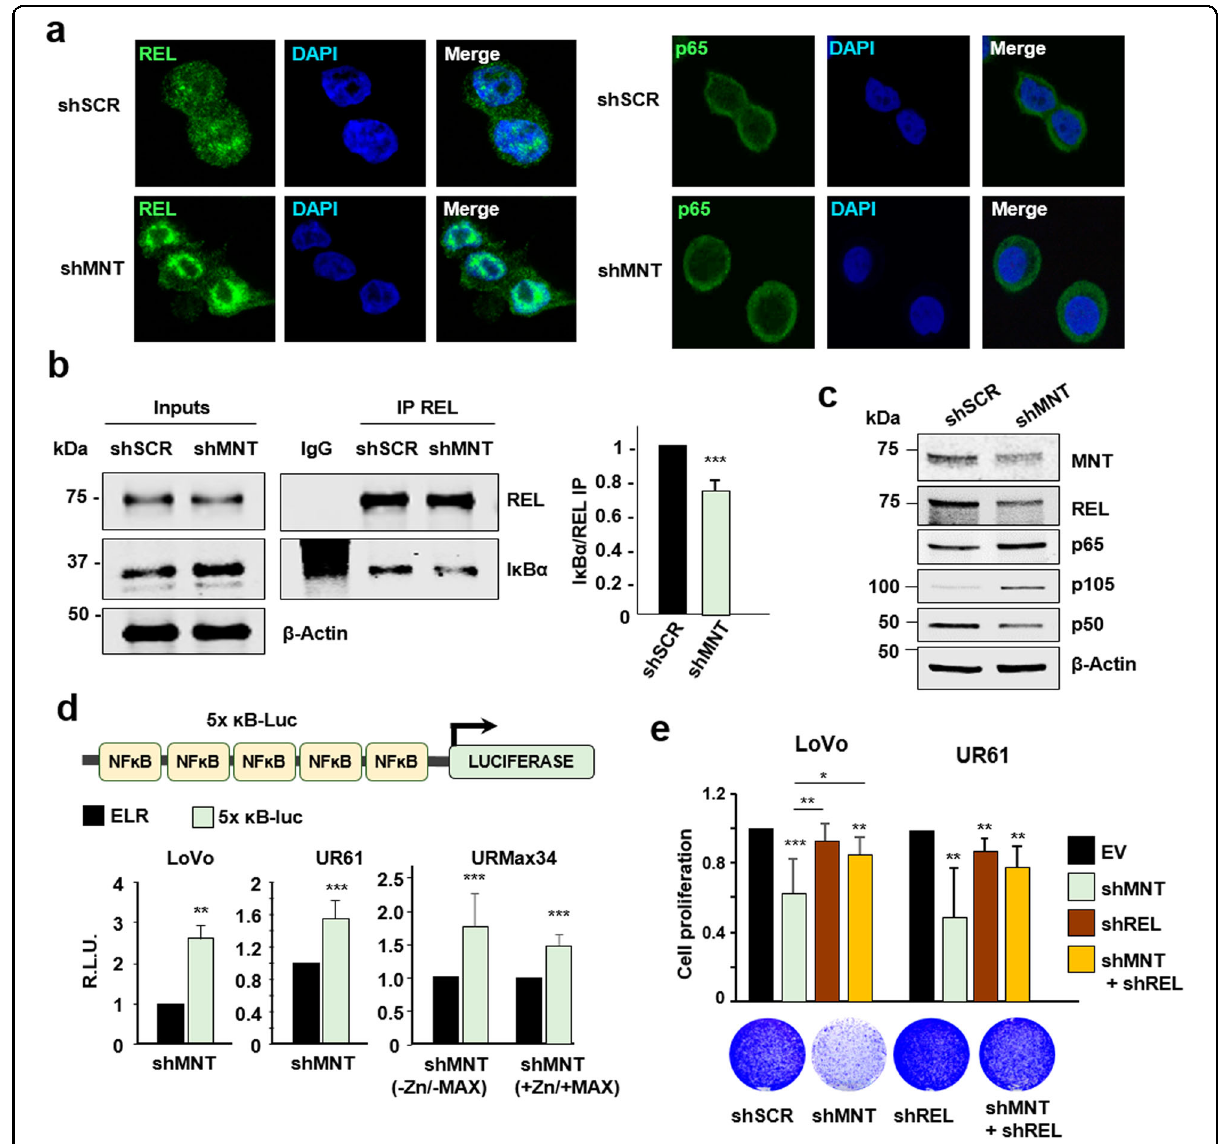
Fig. 4 MNT acts as a repressor of the NF- κ B ’ s pathway. a Immuno fl uorescence of REL (left panel) or p65 (right panel) in LoVo cells that were infected with lentiviral particles carrying two shRNAs against MNT (shMNT) or a scrambled shRNA (shSCR), and selected with puromycin (1 µg/mL) for 72 h. DAPI as a nuclear marker. b LoVo cell lysates 72 h after infection with shRNAs against MNT (shMNT) or a scrambled shRNA (shSCR), as control were immunoprecipitated with anti-REL antibodies (IgG as negative control). The immunoblots of REL and I κ B α in the inputs and the IPs are shown. Right graph: the protein levels of the I κ B α co-IP versus the REL IP in both conditions were quanti fi ed. The data are shown as the mean ± S.D., n = 2, ** P < 0.05. c Protein levels of MNT, REL, p65, p105/p50 in LoVo cells 72 h after infection with lentiviral particles carrying two shRNAs against MNT or a scrambled shRNA (shSCR), as a control. β -Actin used as a protein loading control. d Top: Schematic representation of the luciferase reporter driven by fi ve NF- κ B binding sites used in these experiments (pNF-kB-Luc). Bottom: NF- κ B-mediated promoter activity. LoVo cells were infected with lentiviral particles carrying two shRNAs against MNT (or a scrambled shRNA as a control, shSCR). Then, 48 h after the infection, cells were selected with puromycin (1 µg/mL) for 72 h and then transfected with the luciferase reporter. Cells were harvested 48 h after the transfection with the luciferase constructs and the luciferase activity determined. UR61 and URMax34 cells were transfected with the shRNAs and luciferase constructs and harvested 72 h after the transfection for the luciferase assay (URMax34 cells untreated and treated with 100 µM ZnSO 4 for 24 h). Results are expressed in relative luciferase units (R.L.U.) after normalizing each condition fi rst to the empty luciferase reporter (ELR) and then to the shSCR vector. The data are shown as the mean ± S.D., n = 3 (LoVo), n = 4 (UR61 and URMax34). ** P < 0.05, *** P < 0.01. e REL is required for MNT function in maintaining cell proliferation. UR61 and LoVo cells were infected with lentivirus expressing short-hairpin (sh) RNA sequences for silencing MNT and REL as indicated. Seven days after infection the cells on the plates were stained with crystal violet and the color was quanti fi ed ± S.D. The data were normalized to the proliferation of cell infected with the lentiviral empty vector (EV), n = 4 (LoVo) or n = 3 (UR61)), * P < 0.1, ** P < 0.05; *** P < 0.01. Images of the LoVo stained plates on day 7 of a representative experiment is shown below.